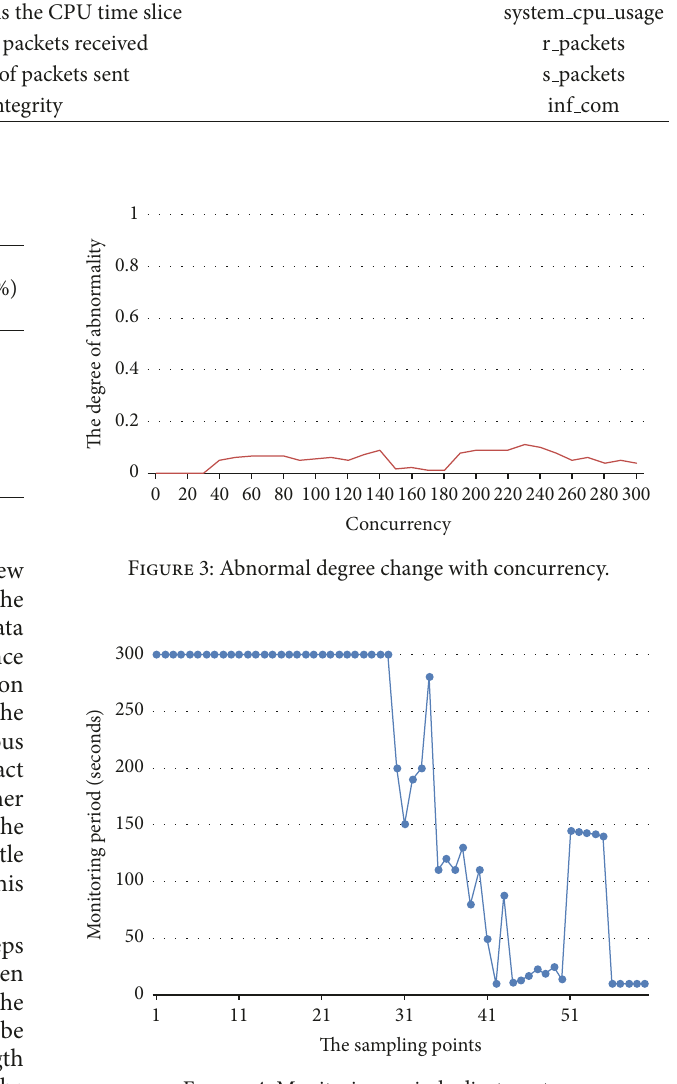
Figure 4: Monitoring period